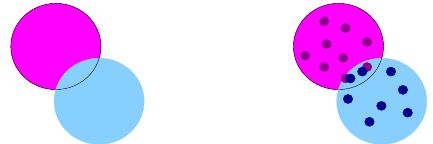
Figure 4. Schematic view for the transverse overlap of parton clouds of the colliding protons for a uniform parton distribution in the proton disk ( left ) and for a clumpy profile of the proton ( right